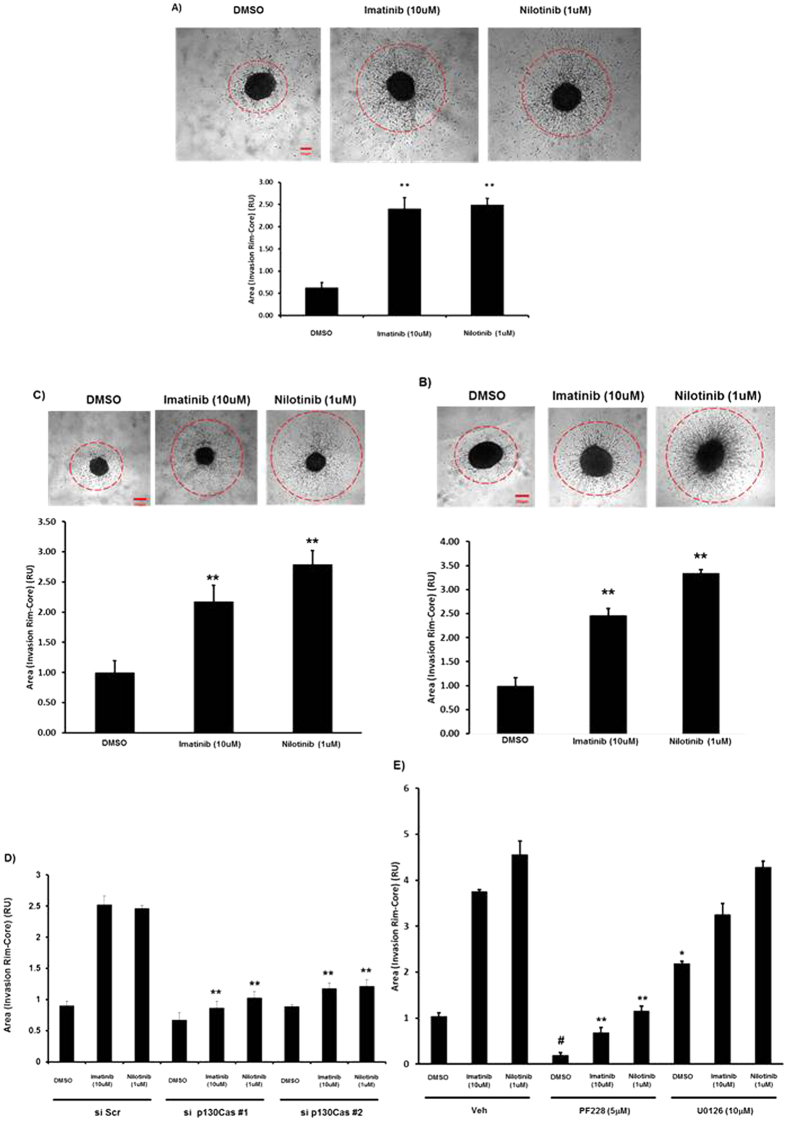
Imatinib and Nilotinib treatment of human GBM cells leads to increased 3D radial invasion of GBM cell spheroids (A) U87MG. (B) U251MG. (C) U118MG. (A–C) Equal amounts of cells were used to generate spheroids as described in Materials and Methods. 24 hours after spheroid production, spheroids were imbedded in a collagen gel and incubated in either SFM & DMSO vehicle control or 10 μM imatinib or 1 μM nilotinib for an additional 48 hours. **p < 0.01 compared to SFM & DMSO vehicle control. (D) Spheroids derived from U87MG cells treated with siRNA to p130Cas (si p130Cas #1 & #2) or control scrambled siRNA (siScr) were imbedded in collagen containing either SFM & DMSO vehicle control or 10 μM imatinib or 1 μM nilotinib and treated as above. **p < 0.01 compared to imatinib and nilotinib siScr respectively.(E) Spheroids derived from U87MG cells were imbedded in collagen containing either SFM & DMSO vehicle control, 5 μM PF573228 or 10 μM U0126 and treated as above. **p < 0.01 compared to imatinib and nilotinib DMSO vehicle control respectively. #p>0.05 compared to SFM & DMSO vehicle control. Spheroids were fixed in 4% PFA and invasion was determined by measuring the area corresponding to the invasion rim minus the area of the core for at least 3 different spheroids per condition. Data from three independent experiments are presented as relative area units (RU) (means +/− s.e.m.).